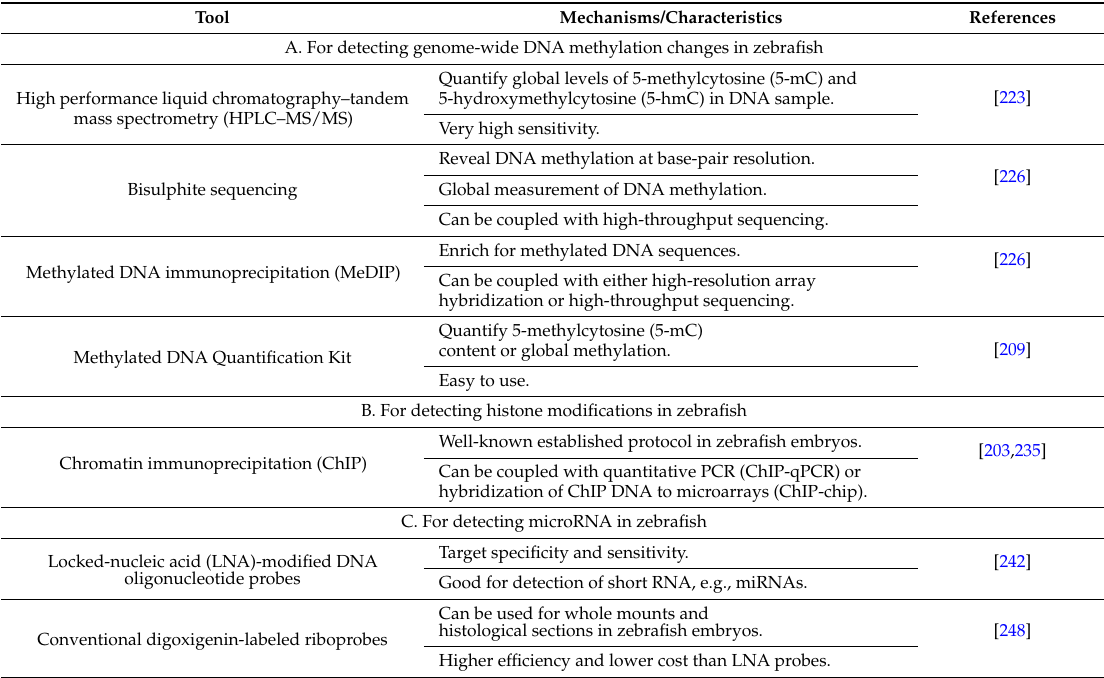
Table 1. A summary of tools for analyzing epigenetic changes in zebrafish, including those for detecting genome-wide DNA methylation changes, histone modification changes as well as miRNA expression.